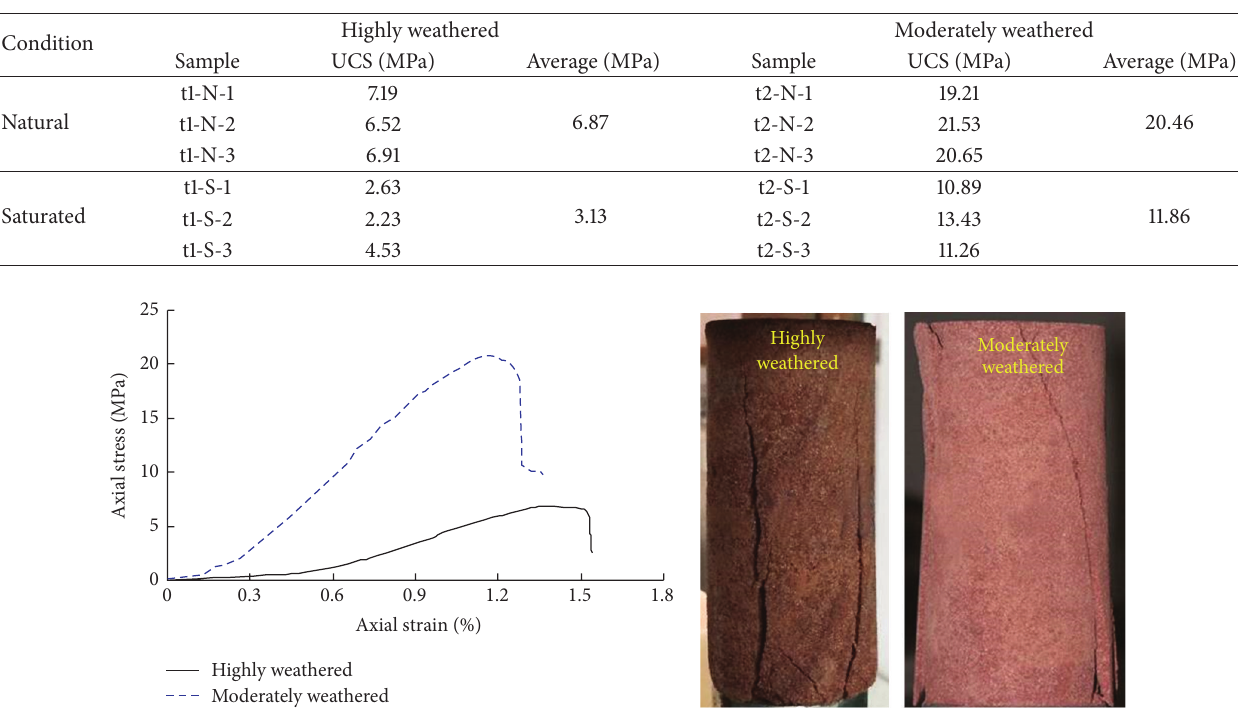
Table 1: The uniaxial compressive strength of the argillaceous siltstone samples.